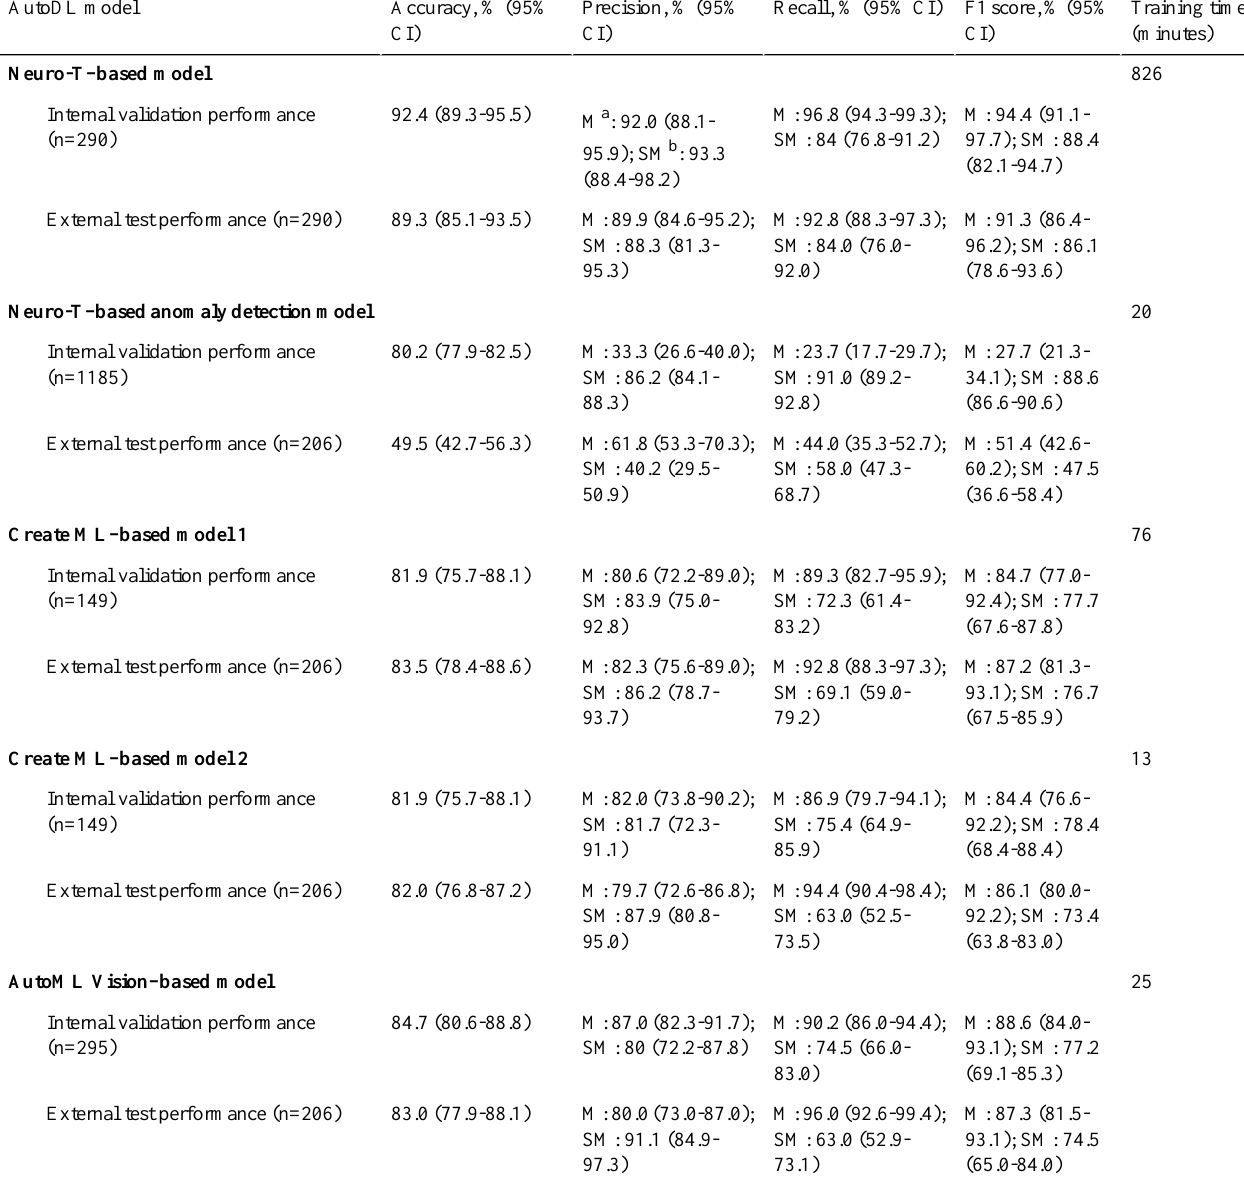
Table 2. Summary of external test accuracy with internal validation accuracy for each automated deep learning (AutoDL)